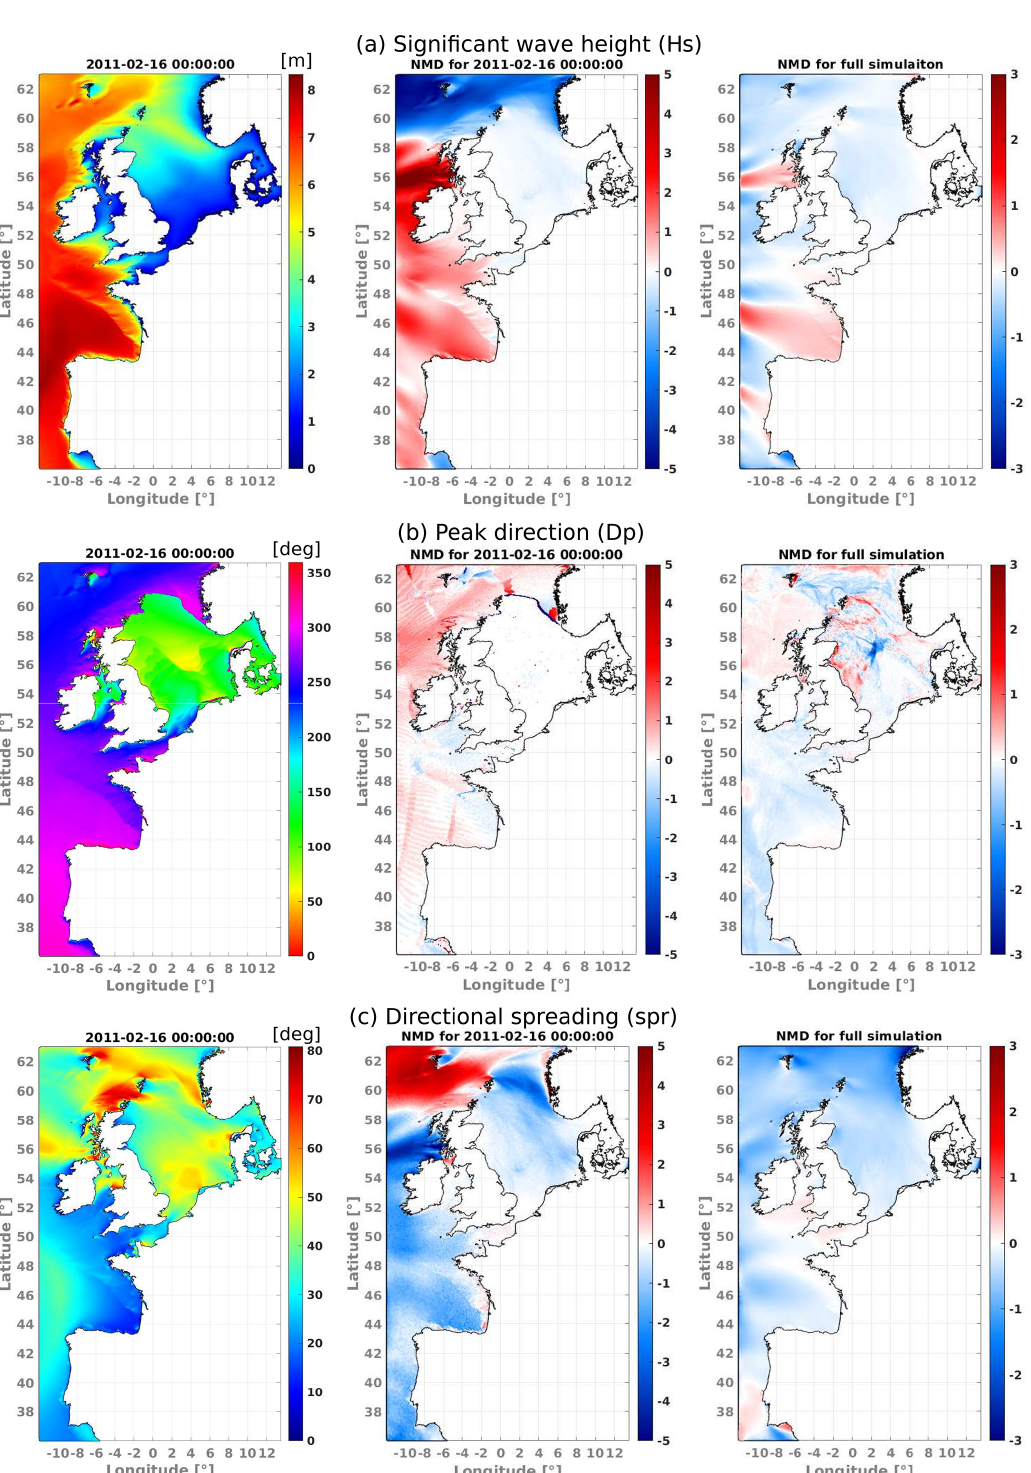
Figure 8. Global current effects over (a) H s , (b) D p , and (c) directional spreading. In the left panels, model output for a test using BC generated with global currents from 16 February 2011, 00:00:00UTC. Mean difference results in the middle and right columns are for a test with BC obtained without global surface currents with respect to a test with BC from a global grid forced with global currents. Color bars in the middle and left panels give the normalized mean difference value in percent. Full simulation duration of tests is 1